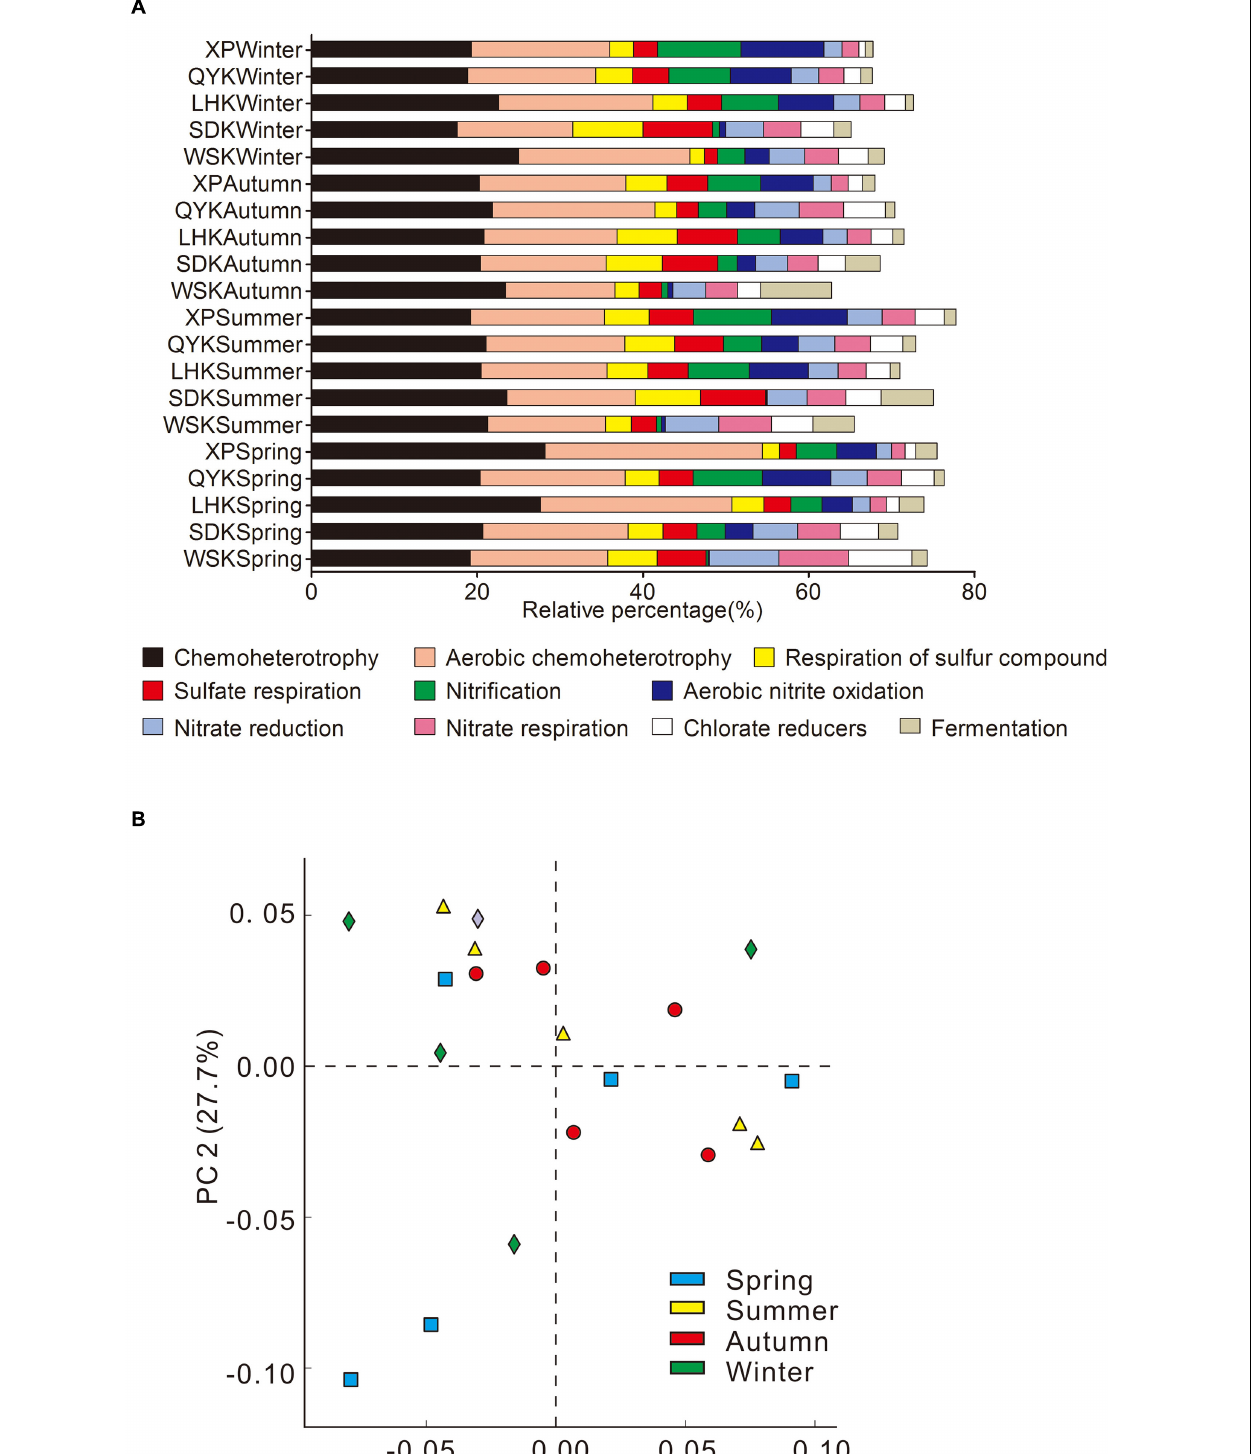
Frontiers in Marine Science |